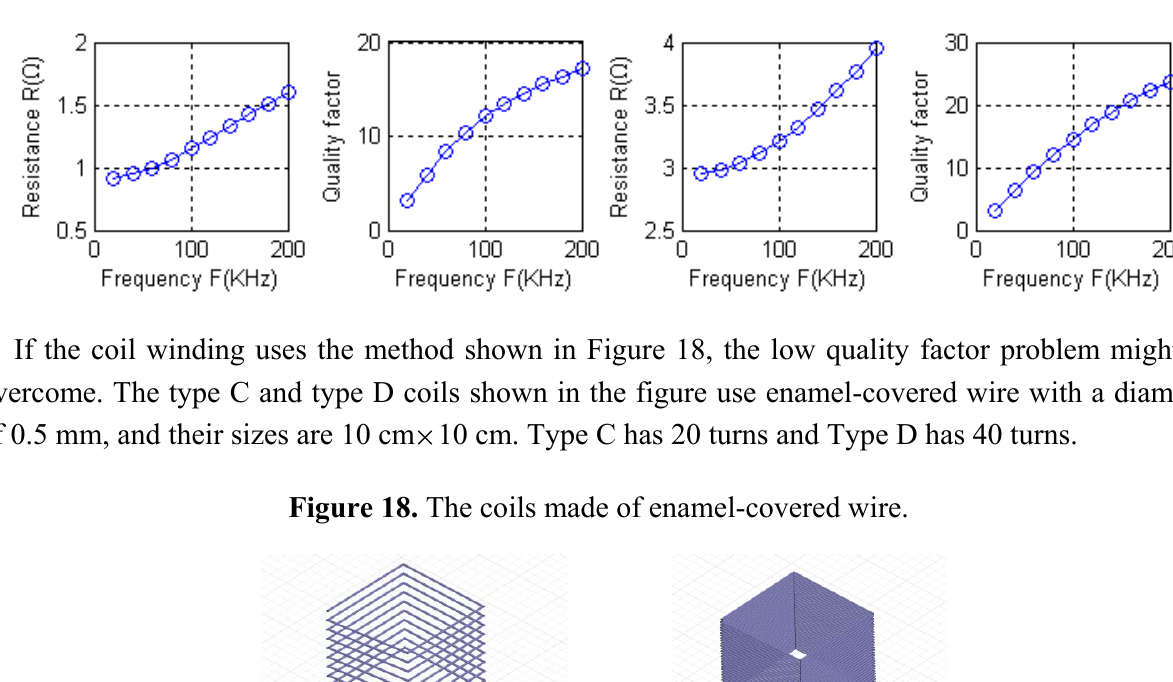
Figure 17. AC impendence and quality factor on the function of frequency.